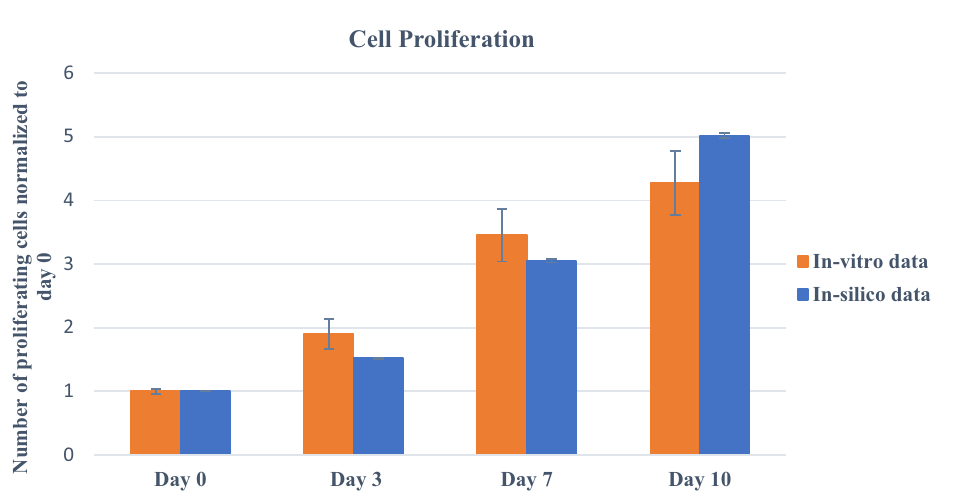
− 1 6 MDA-MB-231 cells mL in